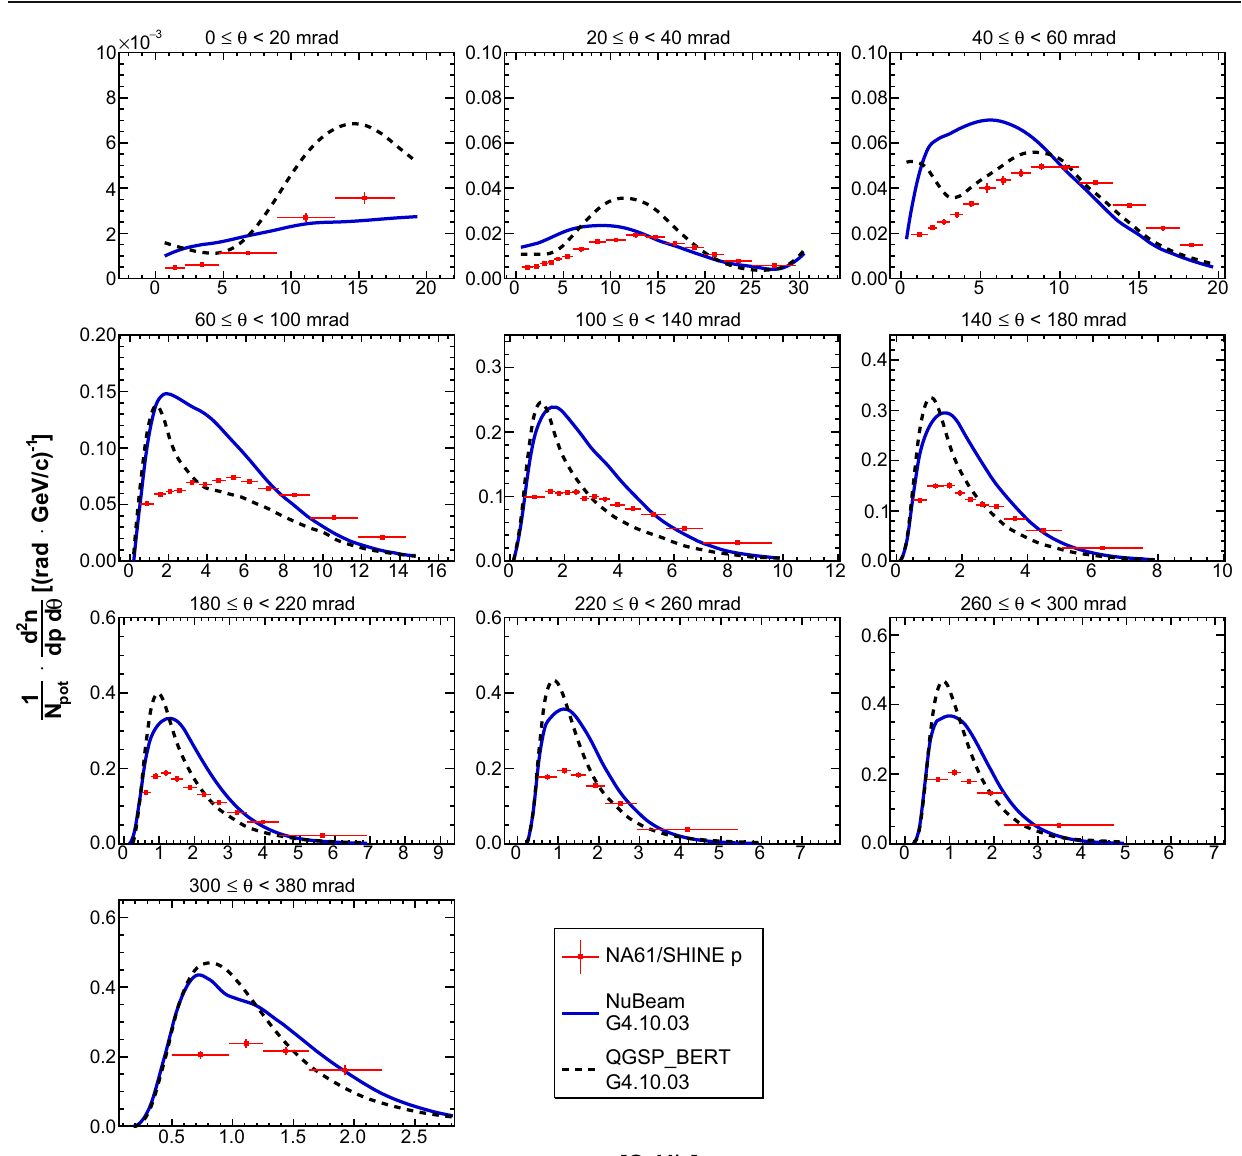
QGSP_BERT (dashed black line) physics lists from Geant4.10 .03 [27,28] are overlaid on top of the